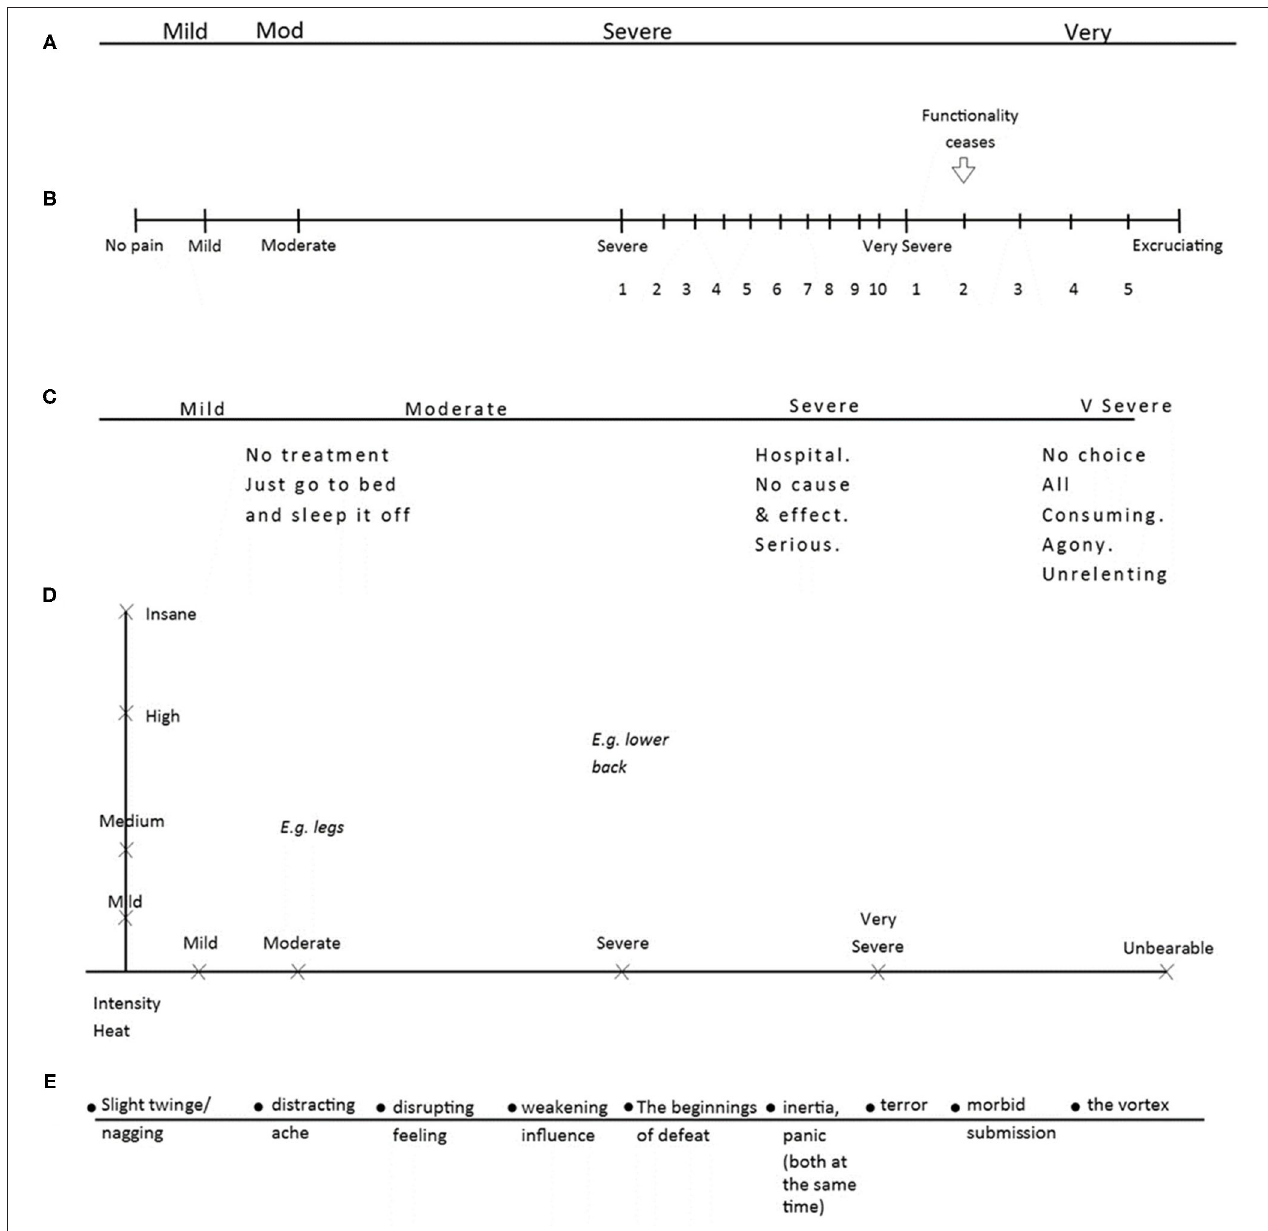
FIGURE 3 | Five personal scales. Five personal scales: (A) P22’s scale, (B) P42’s scale, (C) P11’s scale, (D) P20’s scale, (E) P14’s